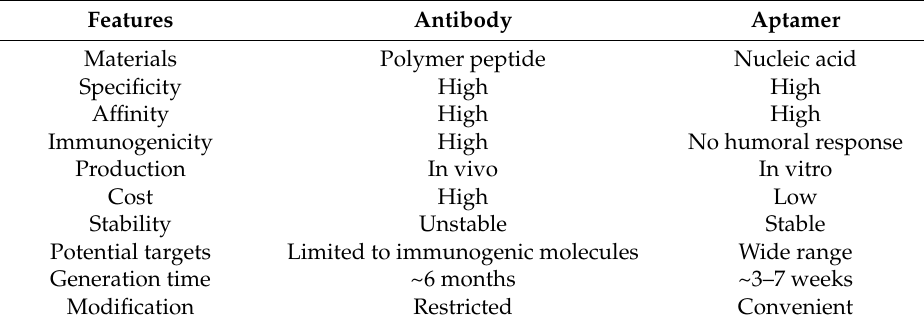
Table 1. Merits of nucleic acid aptamers over protein